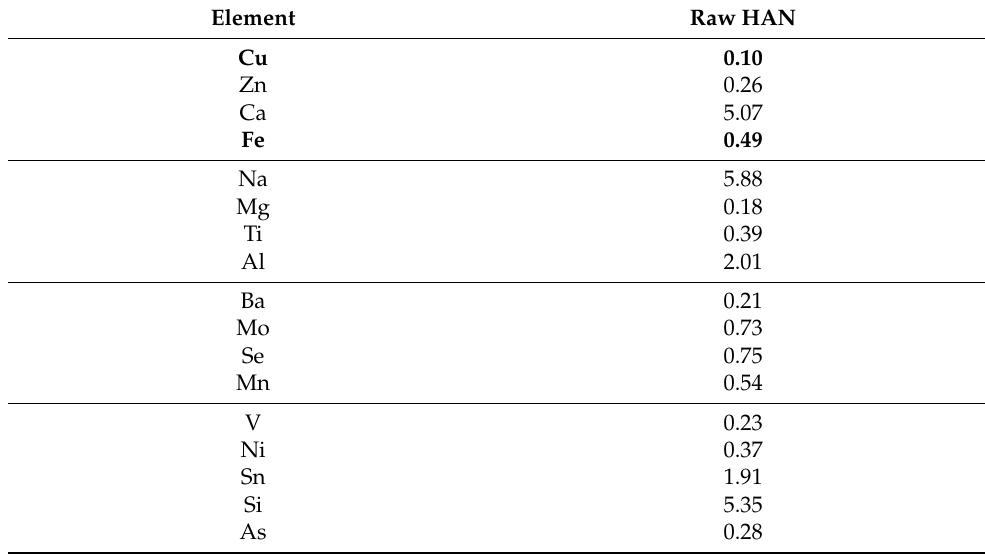
Table 1. Elemental concentration detected by ICP-MS of 45–47% w/w HAN solution, ppm.